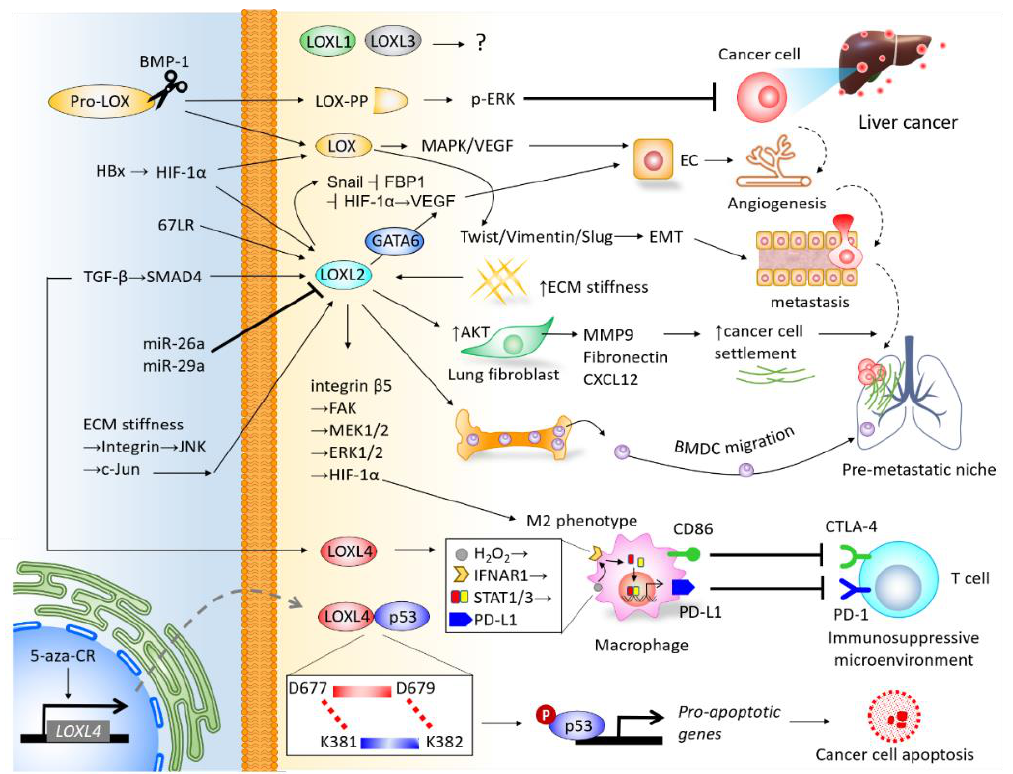
Figure 4. Integrative network depicting the biological roles of LOX family members in the tumor microenvironment (TME) of liver cancer.